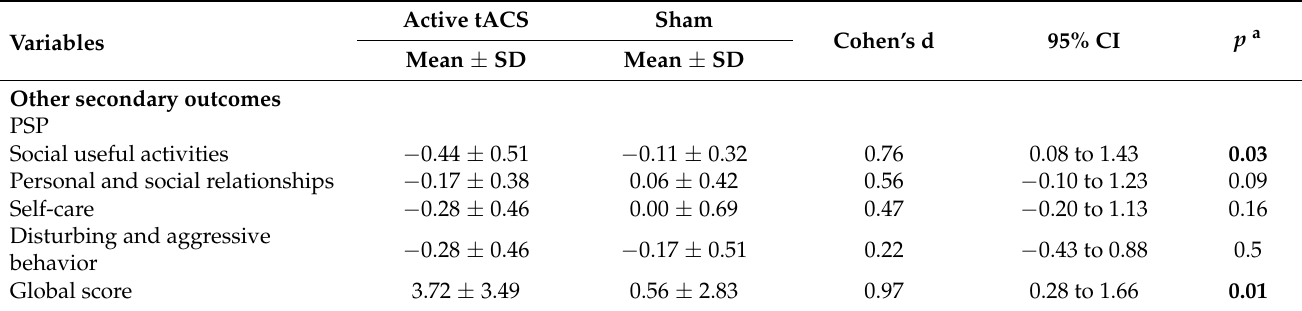
Table 3. Changes in other secondary outcomes of participants treated with 10 sessions of active tACS (n = 18) or sham stimulation (n =